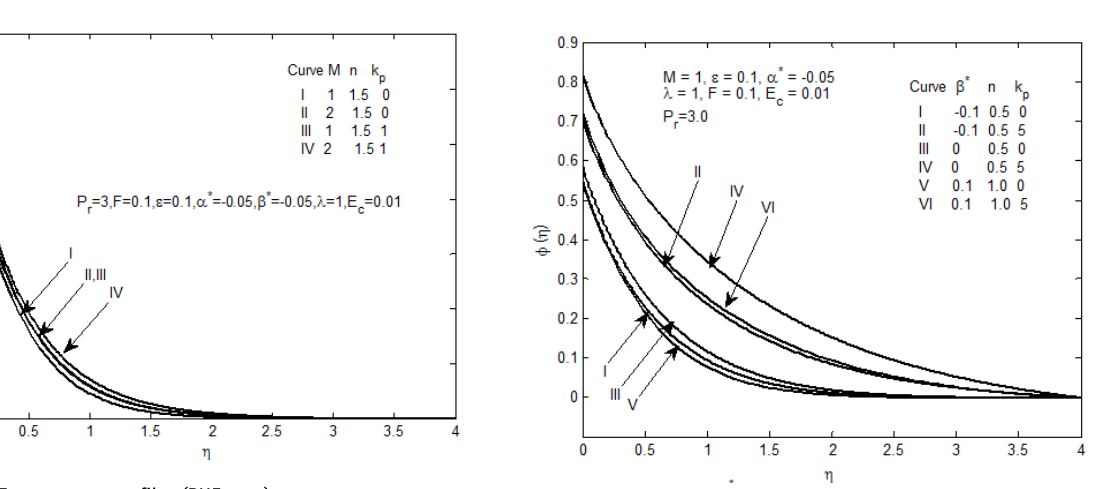
Figure 19: Temperature profiles (PHF